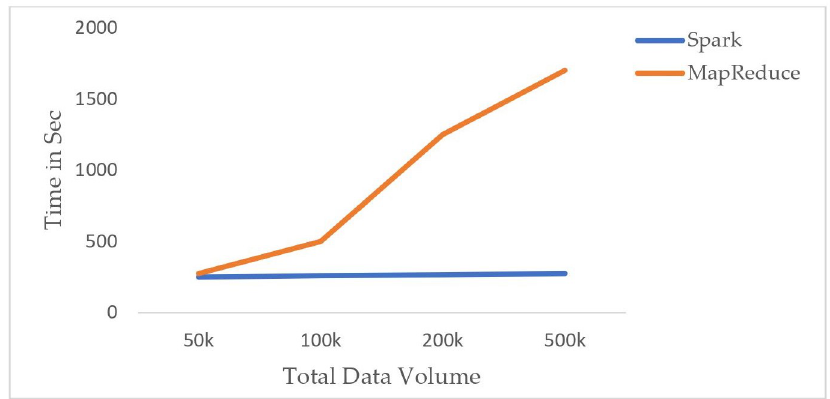
Figure 3. Performance on score calculation.